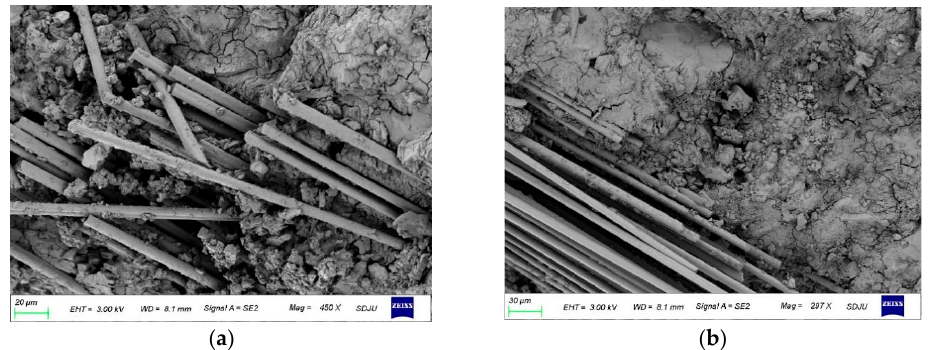
Figure 5. The SEM images of the MPC-based FRiP composites: The ( a ) good and ( b ) poor impregnation of the fibers with the MPC.